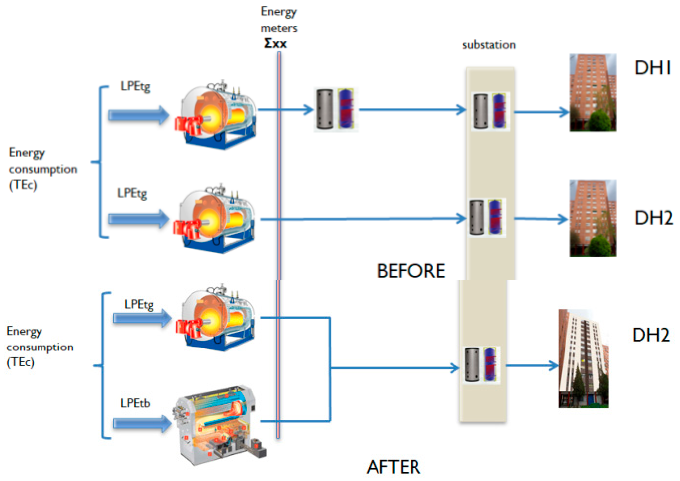
Figure 2. KPIs for energy efficiency and schemas of